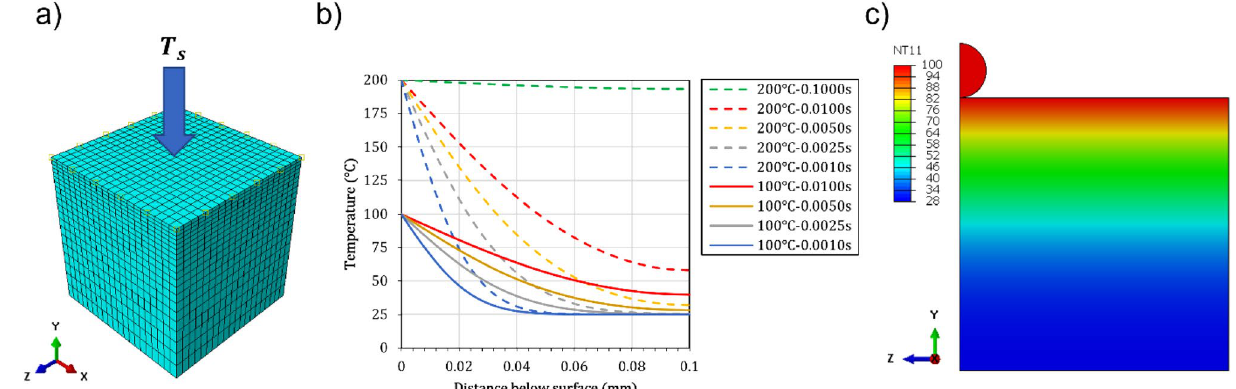
Figure 2. ( a ) Thermal analysis FE model for the estimation of the temperature gradient in the topmost surface ( b ) typical superficial temperature gradients obtained as an outcome of the thermal model ( c ) application of thermal gradients as an initial condition to the single-particle impact model.